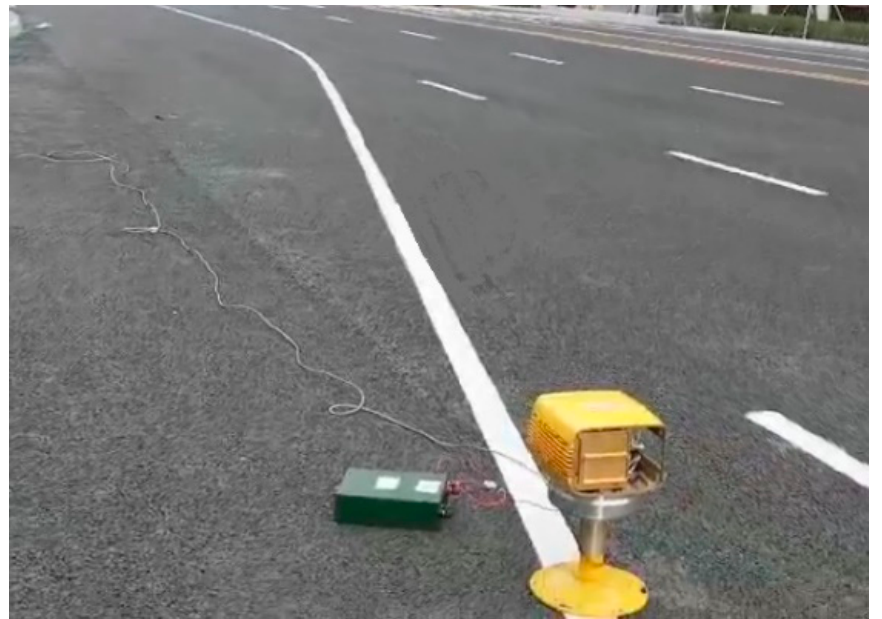
Figure 12. Field measure scenario.